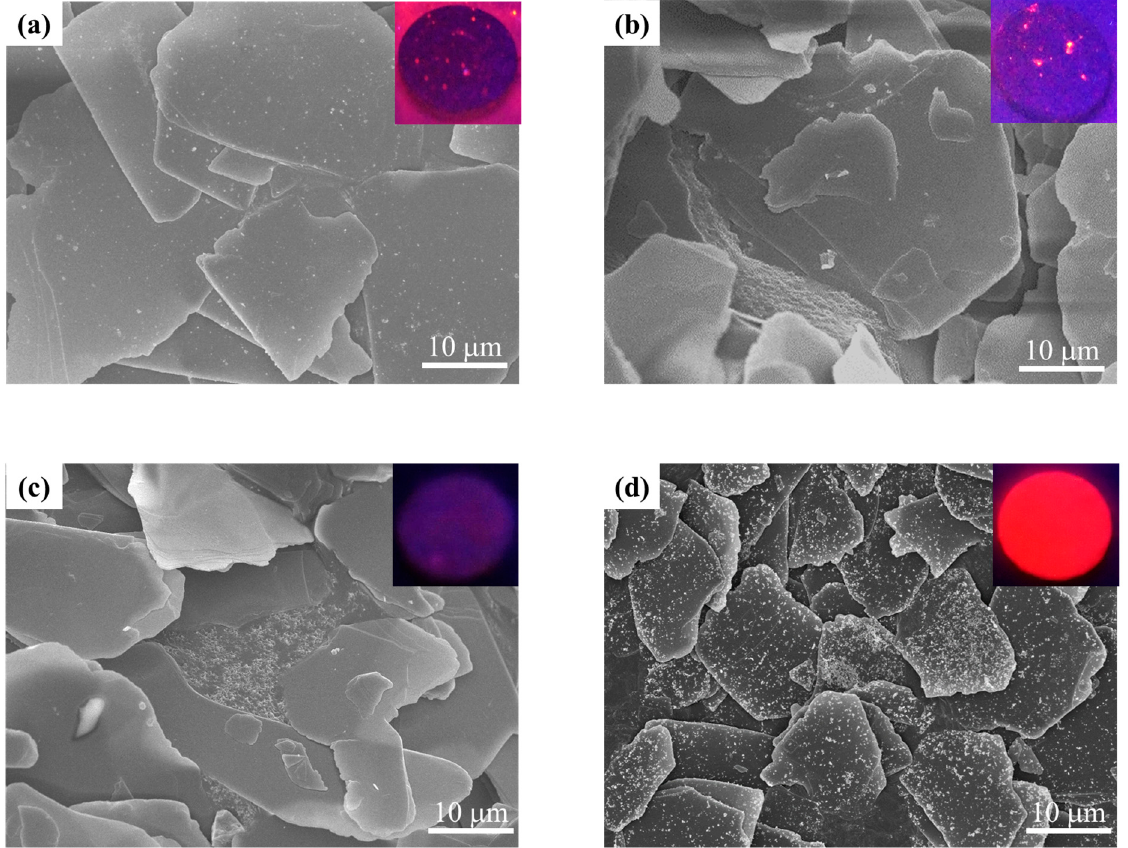
Figure 4. FE-SEM images and inserted fluorescent pictures, of the powders exposed under UV lamp, of Y 2 O 3 :Eu@MF calcined at 650 °C after coating at ( a ) pH 7 and ( b ) pH 8 in ethanol, ( c ) pH 7, and ( d ) pH 8 in water.